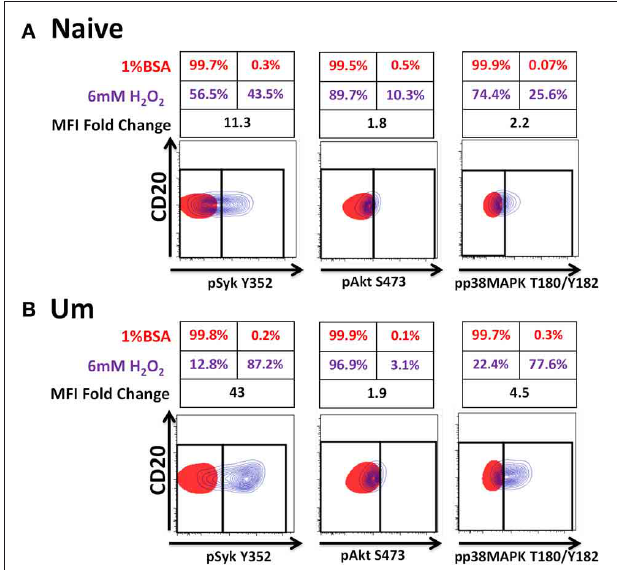
FIGURE 6 | Phosphatases in Um B cells are more susceptible to inhibition by H 2 O 2 . PBMC were treated with 6mM of H 2 O 2 and phosphorylation of proteins associated with the BCR were measured in naïve and Um B cells ( A and B ) after 5min of stimulation at 37 ◦ C. Displayed are overlaps of unstimulated (1% BSA) (red) and stimulated (H 2 O 2 without anti-IgM) (purple) naïve B cells (A) . Similar data display was used for Um B cells (B) . Shown are percentages (red letter/numbers = negative controls; purple letter/numbers = H 2 O 2 stimulation) as well as fold changes in mean fluorescence intensity (MFI) of stimulated compared to unstimulated cells. Um cells showed enhanced phosphorylation of Syk and p38MAPK (B) , compared to naïve B cells (A) . Akt phosphorylation was similar in both cell populations ( A and B ).